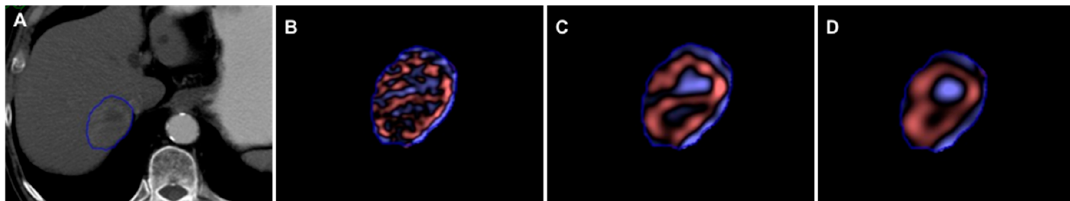
Figure 4. Representative single-slice images at the level of the largest diameter of the LIRADS 5 lesion in the arterial phase were identified and then sent to a commercially available texture analysis research software platform; then, texture features were extracted using commercially available research software. Using the software, a region of interest (ROI) was manually drawn on a single slice corresponding to the largest diameter of the lesion in the arterial phase for non-RPHCC ( A ) for ( B ) fine, ( C ) medium, and ( D ) coarse filters.